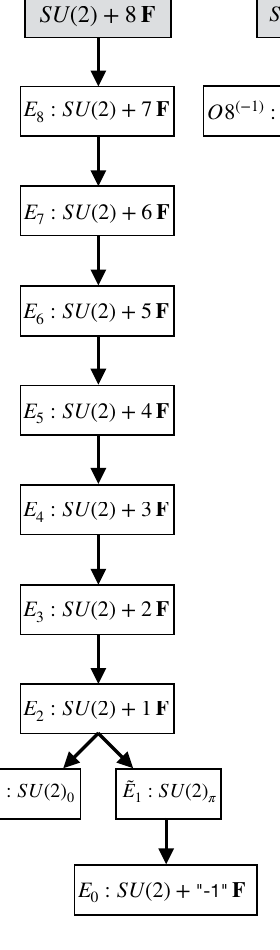
Figure 2 . The RG flow among 5d rank 1 SCFTs obtained by mass deformations. The shaded boxes correspond to 5d KK theories which are UV completed by 6d SCFTs. Each box represents a gauge theory description. Since it is rank 1, the gauge group is SU(2) in all cases, where F represents matter in the fundamental representation and Ad represents matter in the adjoint